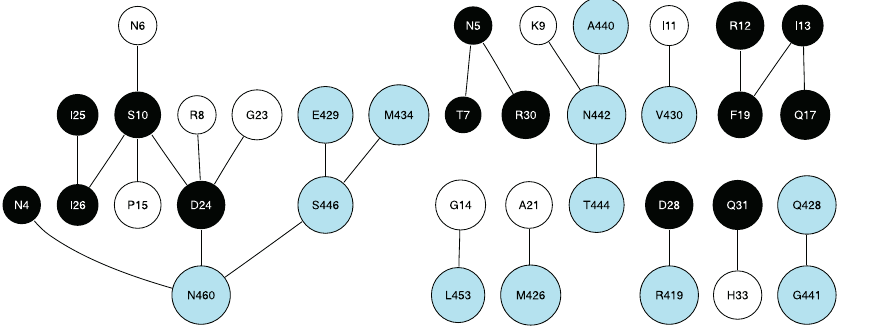
Figure 5. Combined V3 and C4 Network A consensus network assembled from edges with marginal posterior probabilities exceeding 0.95, in which nodes represent nonsynonymous substitution events at codon sites in the V3 and C4 domains. Nodes that correspond to residues in the C4 domain are shaded blue (numbered according to their position in the consensus env gene sequence), and nodes that were connected by strongly supported edges in the V3-specific network are shaded black. We retain the same numbering scheme for residues in V3 for